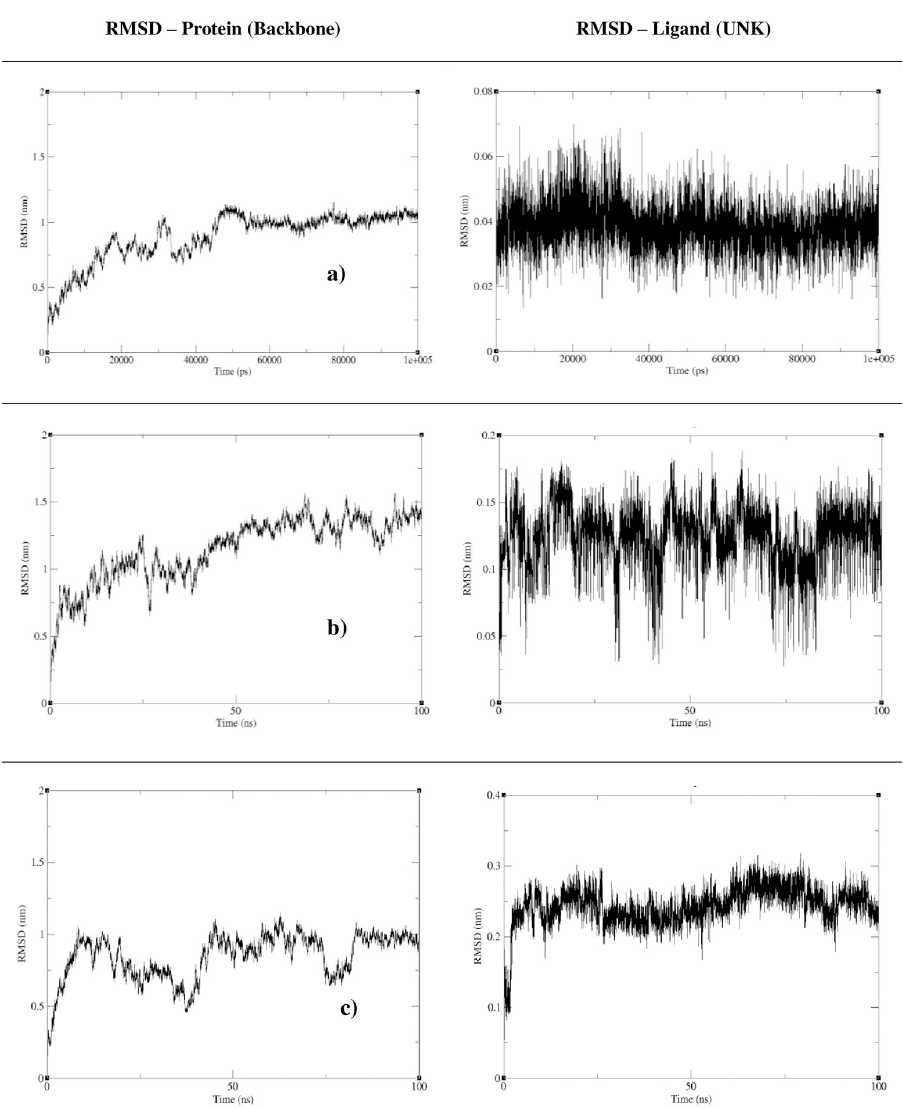
Fig 9. The RMSD plot of IL10 backbone and the ligand complexes. a) RMSD results of IL10 and Guggulsterone; b) RMSD results of IL10 and Herkinorin; c) RMSD results of IL10 and mulberrofuran W.